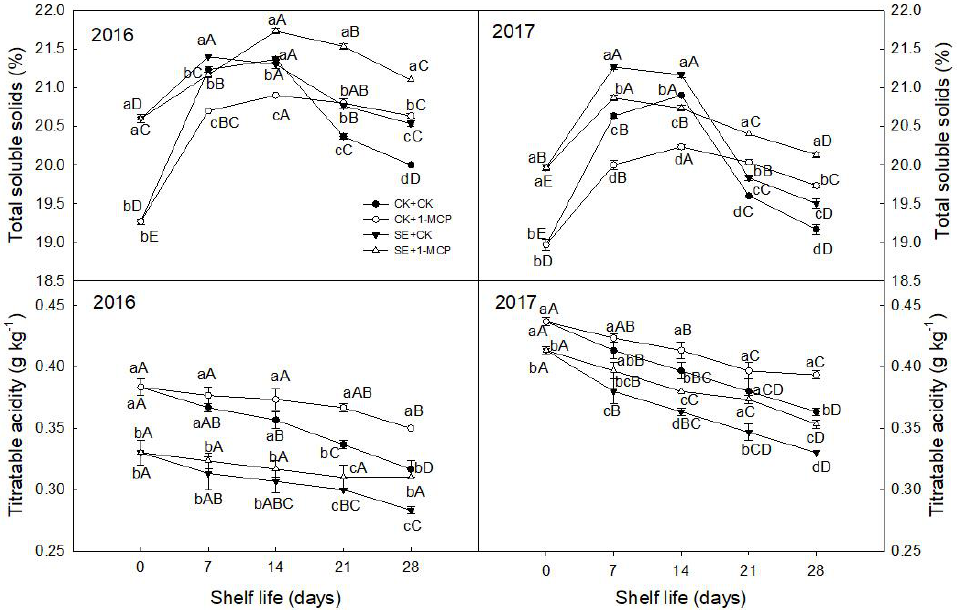
Figure 3. Dynamic changes of titratable acidity and total soluble solids during shelf life period.